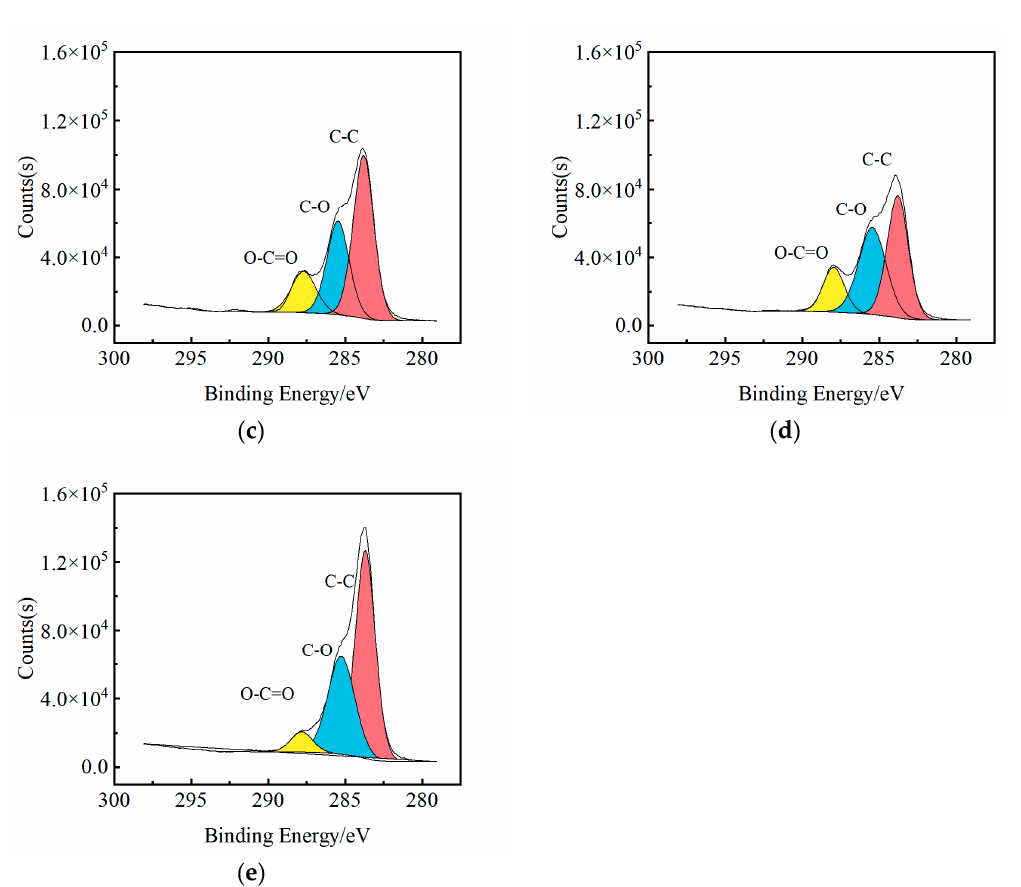
Figure 20. C 1S fitting spectra of XPS on the surface of samples treated with a different number of flame treatments: ( a ) no flame treatments; ( b ) one flame treatment; ( c ) three flame treatments; ( d ) five flame treatments; ( e ) seven flame treatments.